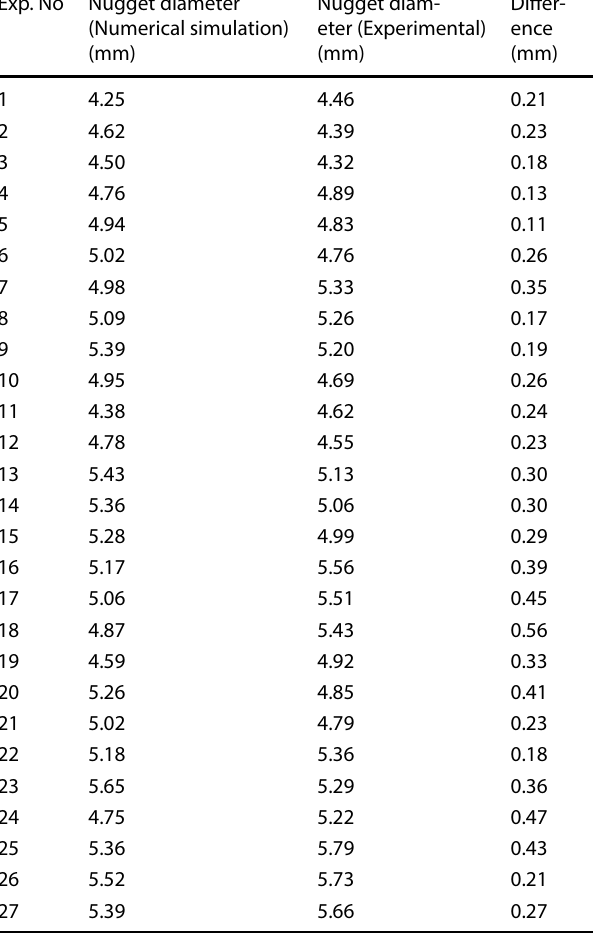
Table 7 Nugget dimeter (Predicted and